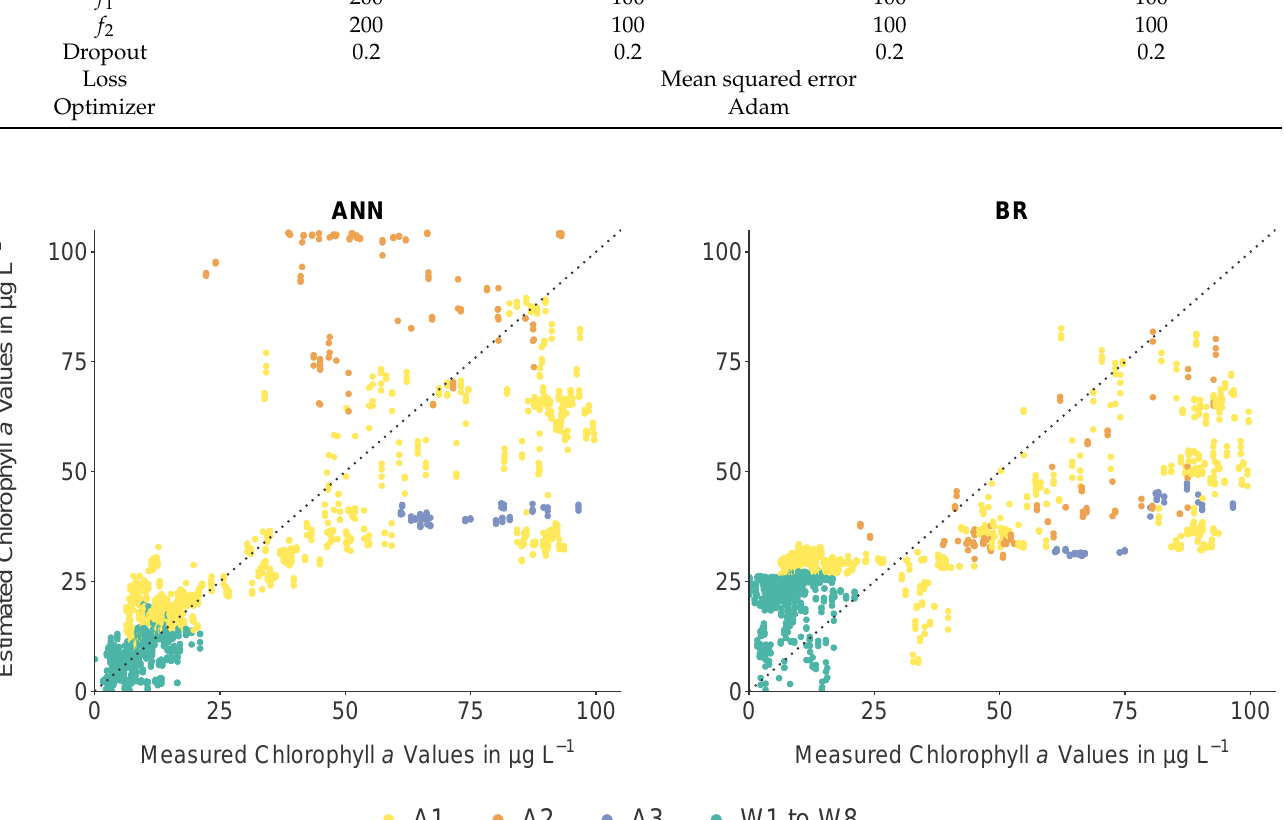
Figure A1. Visualization of the estimation results (y-axes) generated by the ANN and the baseline band ratios (BR) model compared to the measured chlorophyll a values (x-axes) on the SpecWa dataset. The natural water bodies W1 to W8 are colored in green while the artificial water bodies are characterized by three different colors: A1 in yellow, A2 in orange, and A3 in